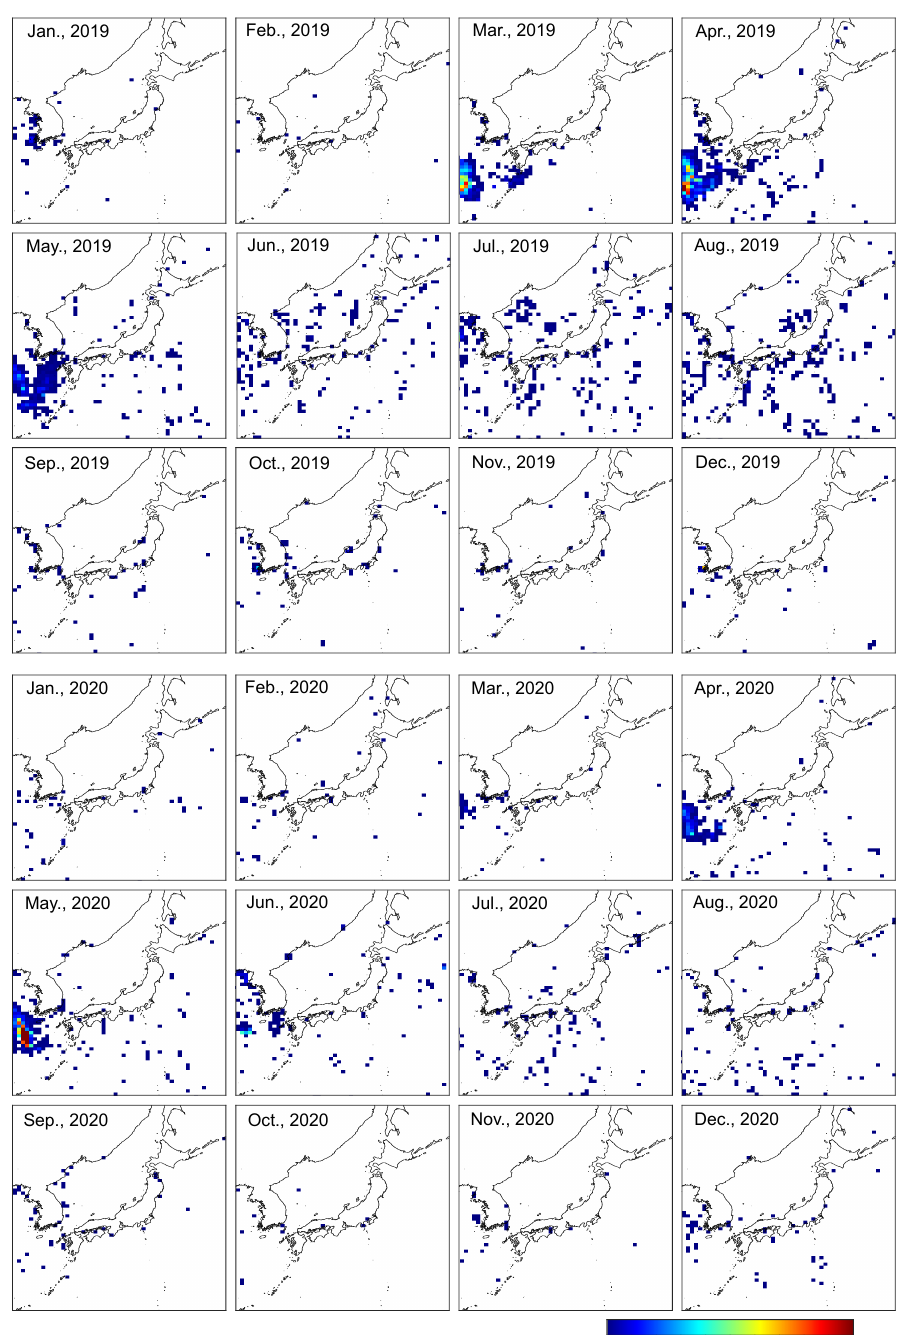
Figure 6. Monthly averaged fractional coverage of floating macroalgae (%; on 0.5 ◦ × 0.5 ◦ grids) from GCOM-C/SGLI FAI Japan area product. The color was specified on 1024 levels, and the fractional coverage below 1 × 10 − 4 % (i.e., 0.1/1024) remained